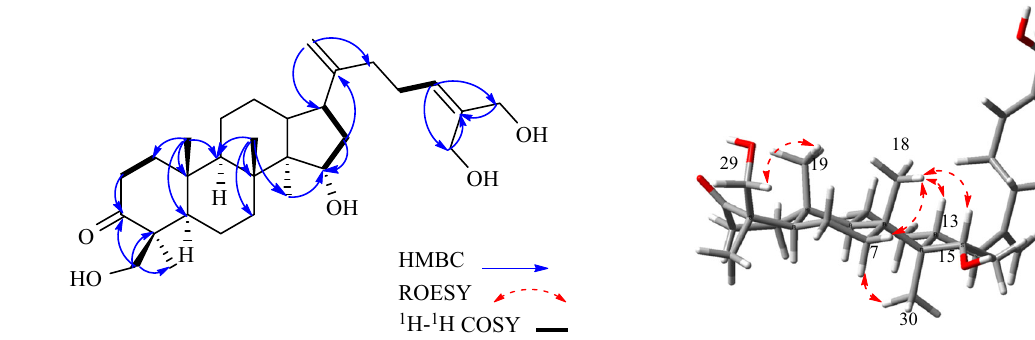
Fig. 3 The key HMBC, ROESY and 1 H– 1 H COSY correlations of compound